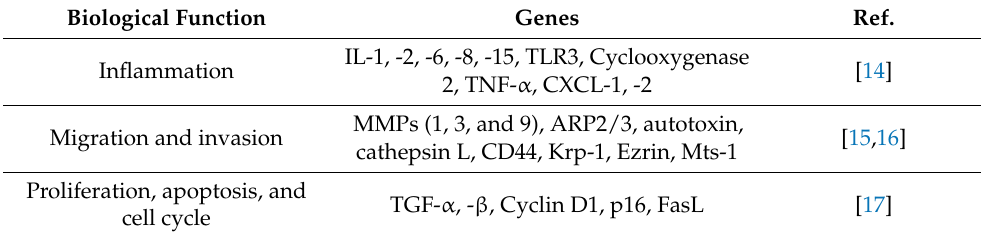
Table 1. Representative genes expressed by